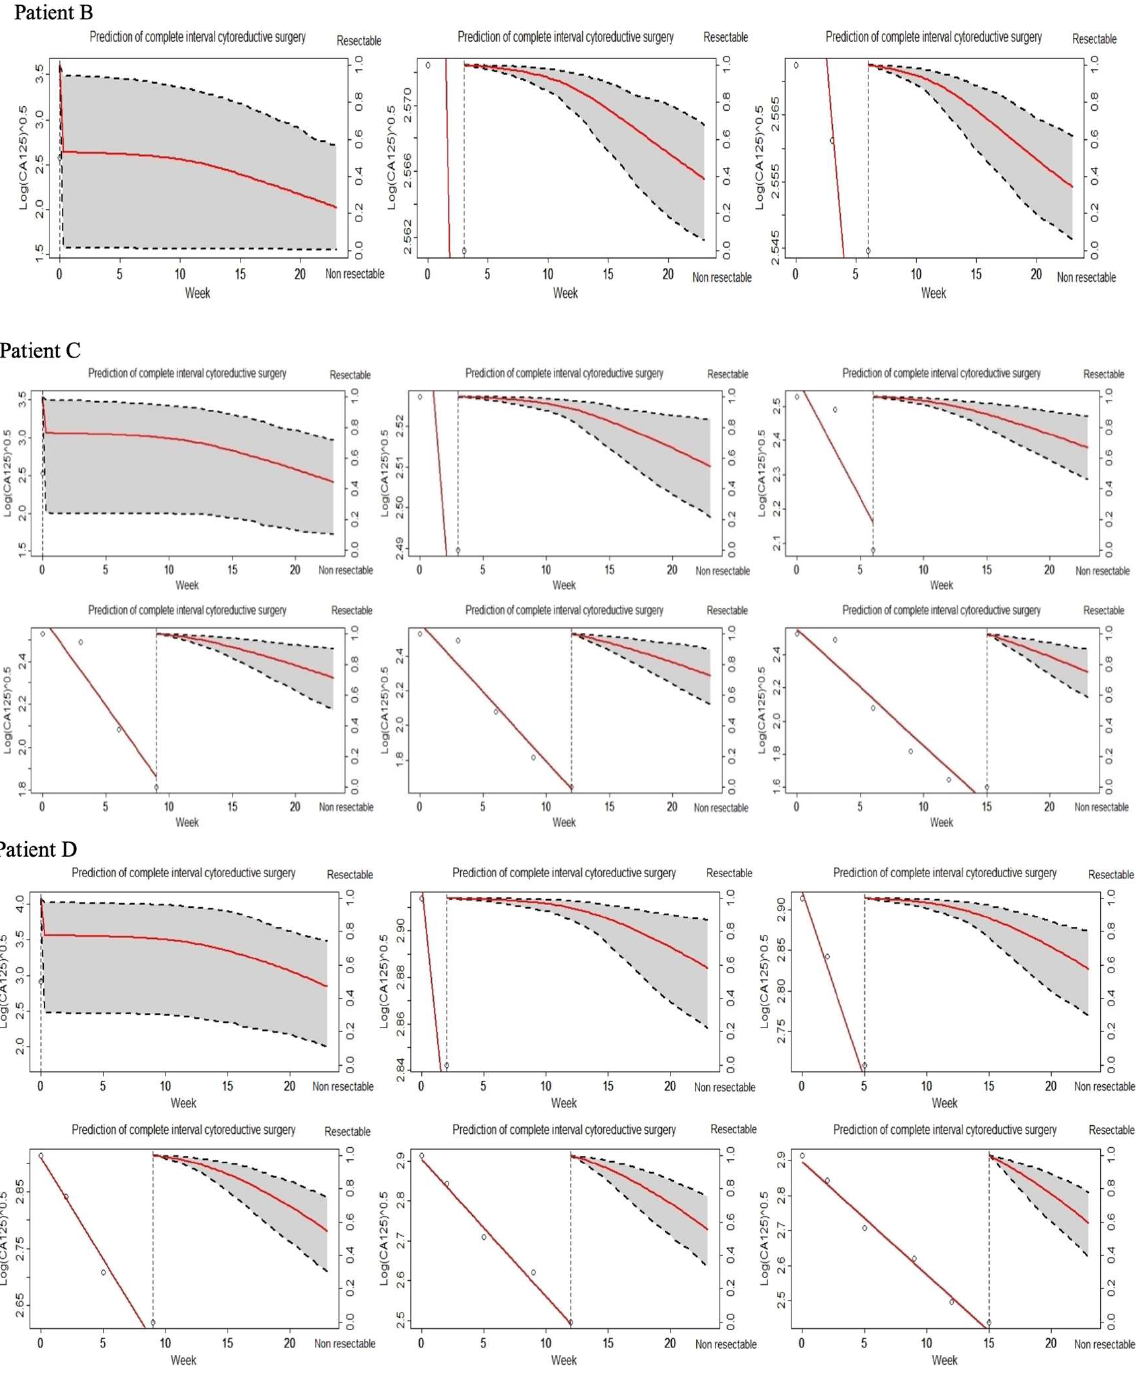
Figure 3. Application of a joint model for dynamic prediction of the probability of complete interval cytoreductive surgery (ICRS) for patients A , B , C , and D . The longitudinal CA-125 values are rep- resented on the left of the vertical dotted line. On the right of the vertical dotted line is the probabil- ity of the feasibility of a complete ICRS. The probabilities of complete ICRS were updated as new CA-125 values were recorded. Patient A with a PS = 1 and without PC located on the epigastrium region at diagnosis. No paracentesis was performed during NAC. This patient underwent 6 courses of NAC. Before NAC, the probability of complete ICRS considering patient characteristics and first CA-125 was under 60%. As new CA-125 values were recorded during NAC, the prognosis was up- dated to a probability of complete ICRS of 75%. A complete ICRS was performed. Patient B with a PS = 0 and the presence of PC located on the epigastrium region at diagnosis. Two paracenteses were performed during NAC. This patient underwent 4 courses of NAC. Initial probability of com- plete ICRS considering patient characteristics and first CA-125 was up to 20%. As new CA-125 val- ues were entered until the end of NAC, the prognosis was updated to a probability of complete ICRS of 36%. For patient B, complete ICRS was not feasible. Patient C was estimated with a PS = 1 and the presence of PC located on the epigastrium region at diagnosis. No paracentesis was per- formed during NAC. This patient underwent 6 courses of NAC. Initial probability of complete ICRS considering patient characteristics and first CA-125 was close to 40%. As new CA-125 values were entered until the end of NAC, the prognosis was updated to a probability of complete ICRS of close to 80%. For patient C, complete ICRS was performed. Patient D was estimated with a PS = 1 and the presence of PC located on the epigastrium region at diagnosis. One paracentesis was performed during NAC. This patient underwent 6 courses of NAC. Initial probability of complete ICRS con- sidering patient characteristics and first CA-125 was close to 45%. As new CA-125 values were en- tered until the end of NAC, the prognosis was updated to a probability of complete ICRS of 60%. For patient D, complete ICRS was not feasible. 4. Discussion In this study, we developed a dynamic and individual accurate predictive model of complete ICRS feasibility in patients with AOC. As part of the JM, an LME sub-model included the number of iterative paracentesis and the number of NAC cycles as covariates affecting the trajectory of CA-125 levels. This allowed a better modeling of the CA-125 kinetics. As predictive covariates, poor PS and the presence of PC in the epigastrium re- gion were included in the Cox sub-model. This JM, with an accuracy > 85% and a predic- tive error < 3%, showed the reliability of the model to predict the resectability of the AOC after NAC. The kinetics of CA-125 levels is correlated to tumor size evolution during NAC, sug- gesting a perspective to predict resectability [17,34]. Indeed, as a result of the NAC ad- ministration, CA-125 levels decrease. Also, the CA-125 level is correlated to the presence and the amount of ascites [35,36]. A poor PS is a well-known risk factor of non-resectability [37]. In our population study, the presence of PC in the epigastrium region (omentum lesser sac, the stomach, and hepatic pedicle) was prohibitive for resectability. This may be explained by the fact that